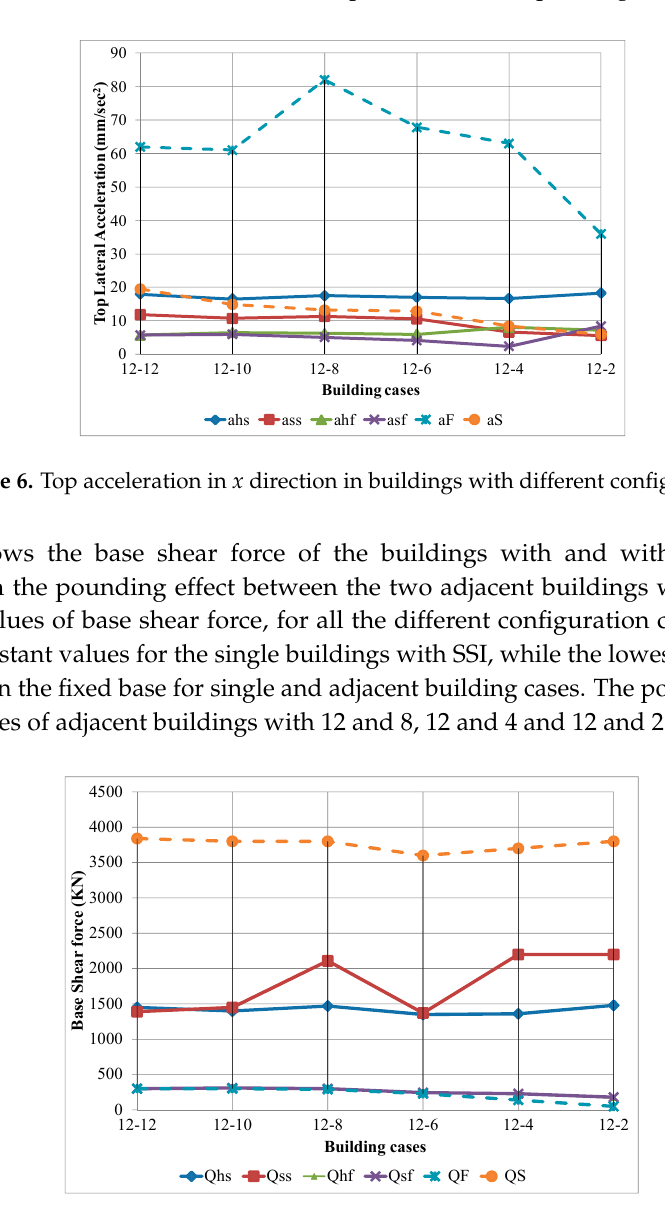
Figure 7. Base shear force in buildings with different configurations.